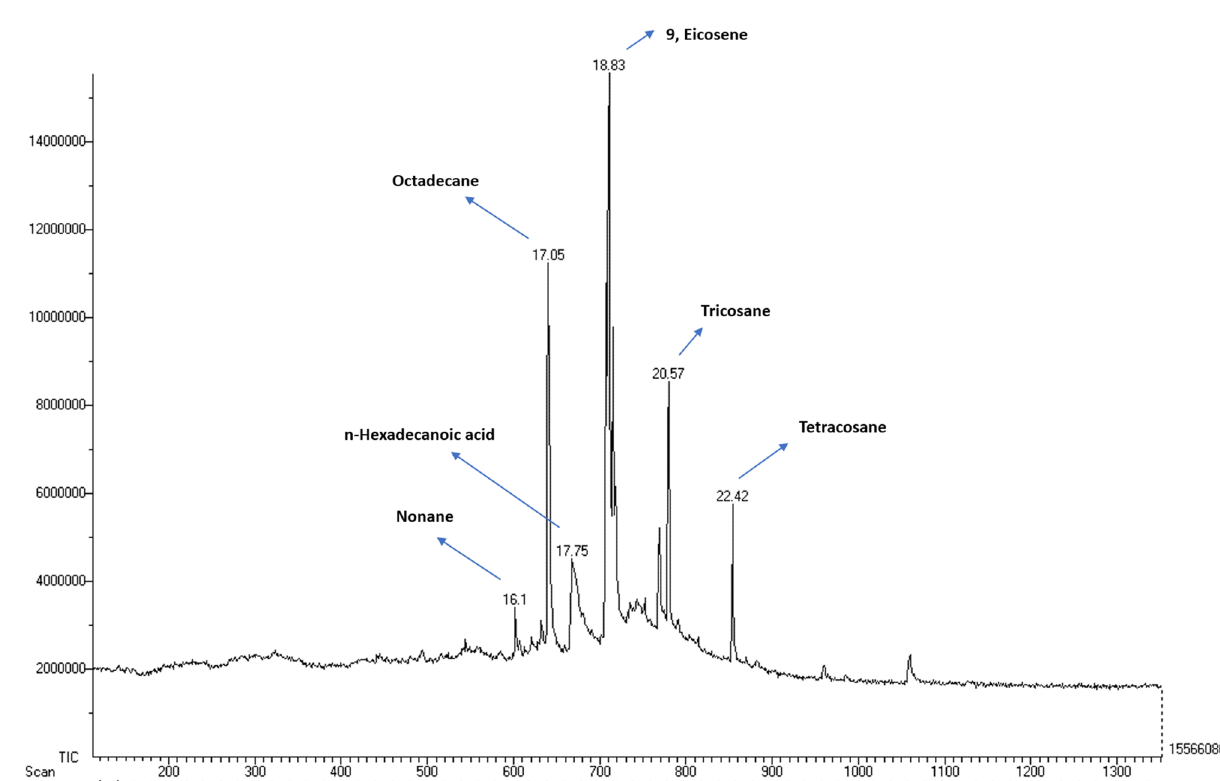
Figure 14. Gas chromatography spectrum of microalga treated sample (with LDPE